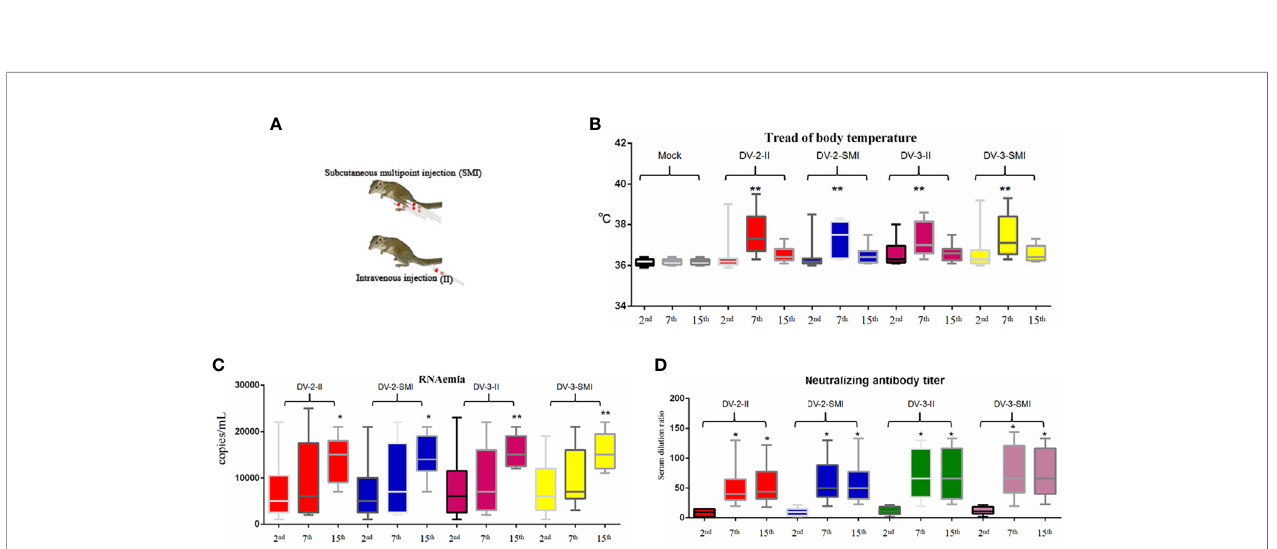
FIGURE 1 | The key innate immune genes of tree shrew are genetically close to Homo sapiens . (A) , The variation of coding amino acid of STING gene in tree shrew ( Tupaia belangeri chinensis), and Homo sapiens . (B – D) , Phylogenetic tree of STING (B) , TLR3 (C) and MDA5 (D) gene of T. belangeri , H. sapiens , Macaca mulatta , Sus scrofa and Mus. The phylogenetic tree was constructed using the Maximum Likelyhood phylogeny test. Bootstrap values were set for 1,000 repetitions. (E, F) Viral replication of DENV-3 in Vero (E) and BM-MSCs (F) cells. DENV-3 genomic RNA was tested from 0 to 96 h post-inoculation in culture supernatants of Vero cells and tupaia